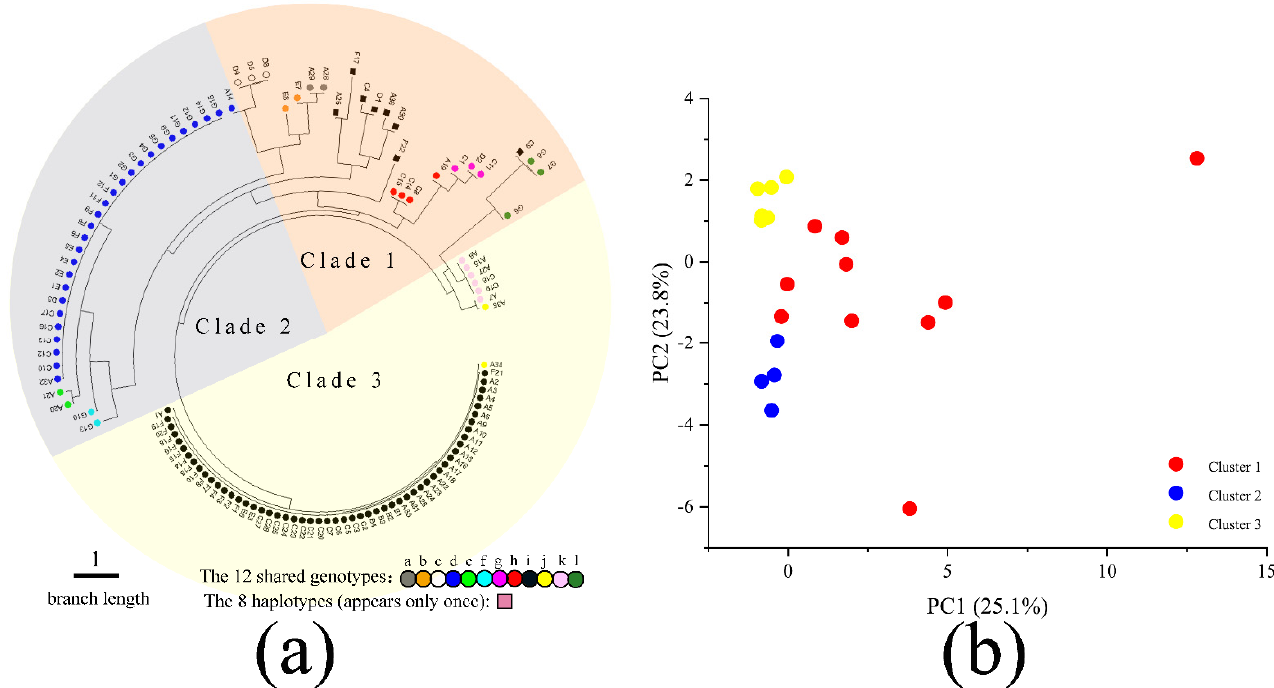
Figure 5. ( a ). Dendrogram obtained for the 118 A. exitialis fruiting bodies based on their genetic distance; ( b ). The hierarchical clustering results of 118 A. exitialis fruiting bodies based on principal component analyses.